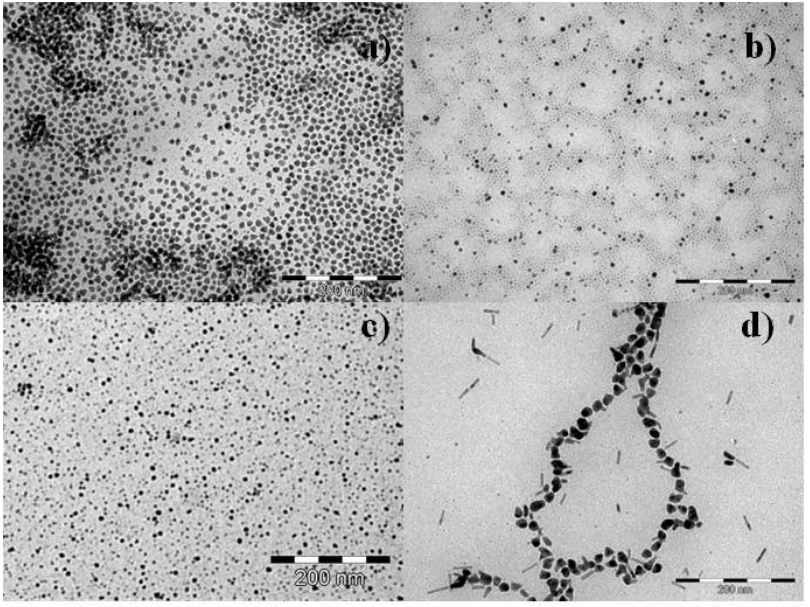
120 °C ( a ) for Boba:HDA:Co = 1:1:1 (1.5wt% Co) after 3 h ( b ) for Boba:HDA:Co = 1:1:1 (1.5 wt% Co) after 24 h ( c ) for Boba:HDA:Co = 0.16:0.16:1 (10wt% Co) after 3 h ( d ) for Boba:HDA:Co = 0.16:0.16:1 (10wt% Co) after 14 h. Scale bars: 200